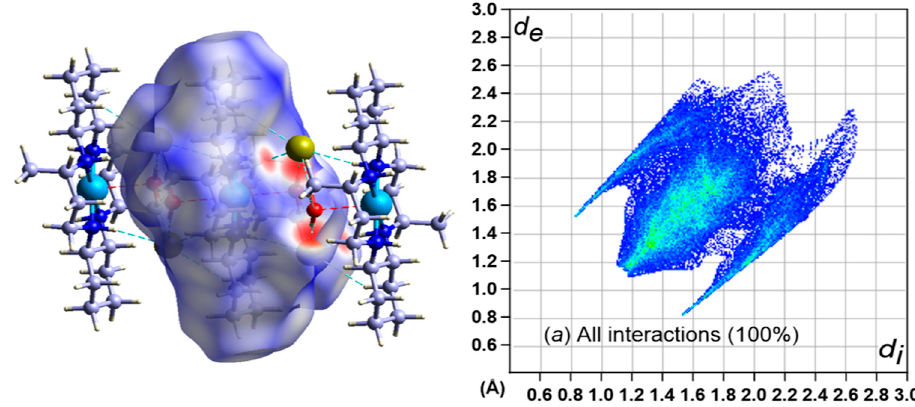
Figure 6. Hirshfeld surface mapped with ( left ) d norm , and 2D fingerprint map ( right ) for all interactions.